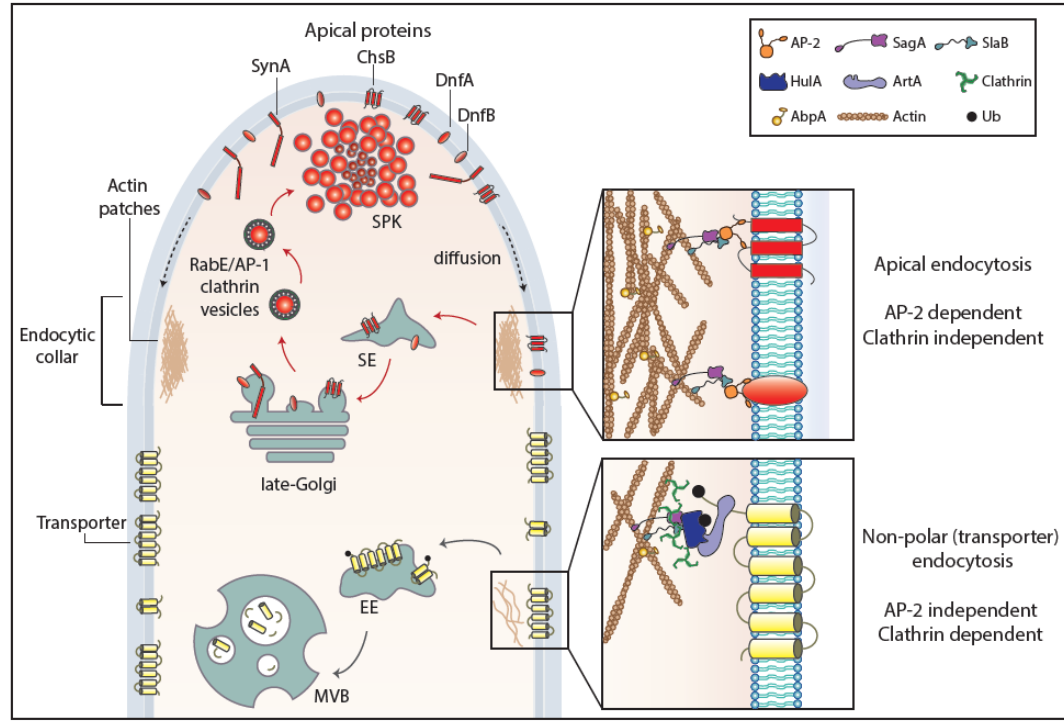
Figure 3. Endocytosis of transporter versus apical cargoes in A. nidulans. Model highlighting the endocytic process of transporters and apical membrane cargoes in a growing hyphal tip of A. nidulans. After reaching the PM, apical cargoes di ff use laterally to the actin-enriched collar region where they undergo AP-2-dependent, but clathrin-independent, endocytosis with the involvement of several endocytosis-related proteins (SagA, SlaB). Endocytic vesicles fuse to sorting endosomes (SEs) and from there undergo retrograde tra ffi c to late-Golgi cisternae and then travel via AP-1 / clathrin-coated vesicles to the SPK and finally to the PM. This model does not exclude (not shown) that a fraction of apical cargoes could be sorted directly to vacuoles to undergo degradation. The ongoing recycling process of apical cargoes ensures constant polarity maintenance and polar cell tip growth. Transporters, which are not polarly localized at the PM, are not cargoes of the AP-2 pathway, but instead follow α -arrestin- and clathrin-dependent endocytosis. Specifically, as a response to physiological or stress signals, transporters are recognized and ubiquitinated by HulA ubiquitin ligase, assisted by α -arrestin adaptors (ArtA). Internalization takes place by a clathrin-dependent, but AP-2 independent, pathway with the recruitment of several endocytosis-related proteins (e.g., SagA, SlaB), followed by sorting into early endosomes (EEs) and eventually degradation to multivesicular bodies (MVBs) [17].